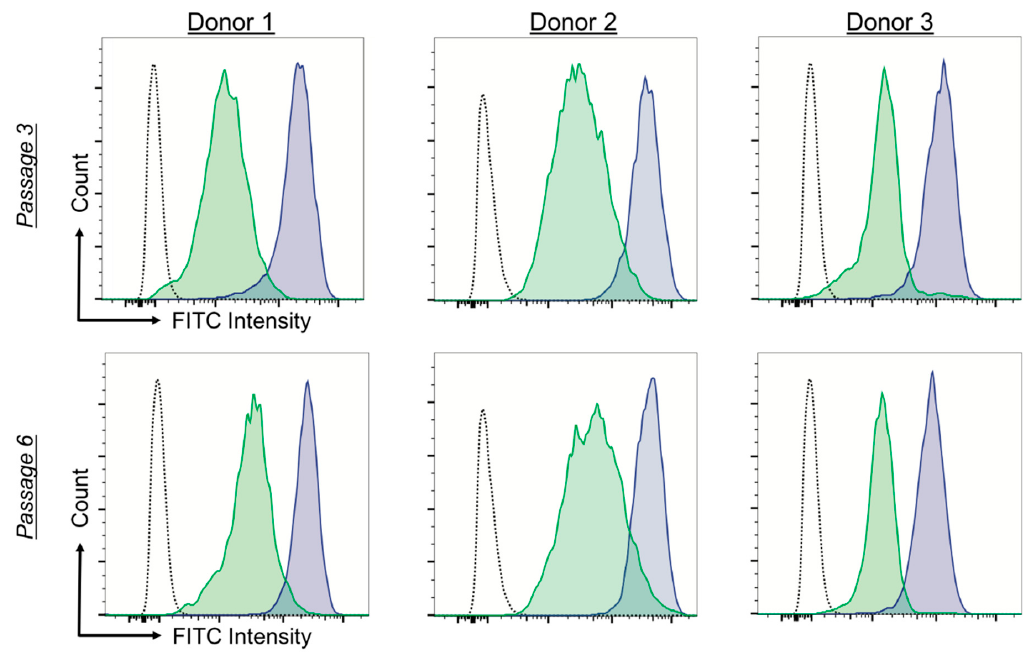
Figure 3. PEG-PCL copolymers reduce intracellular ROS load of donor cells at both passages. Human mesenchymal stem cells ( hMSCs) were incubated with DCFDA, and FITC intensity correlated with active ROS species. The graphs shown are representative results from n = 3 independent experimental replicates. Blue is TCPS and green is PEG-PCL. All donors for both passages had decreased ROS loads for hMSCs grown on PEG-PCL compared to TCPS.